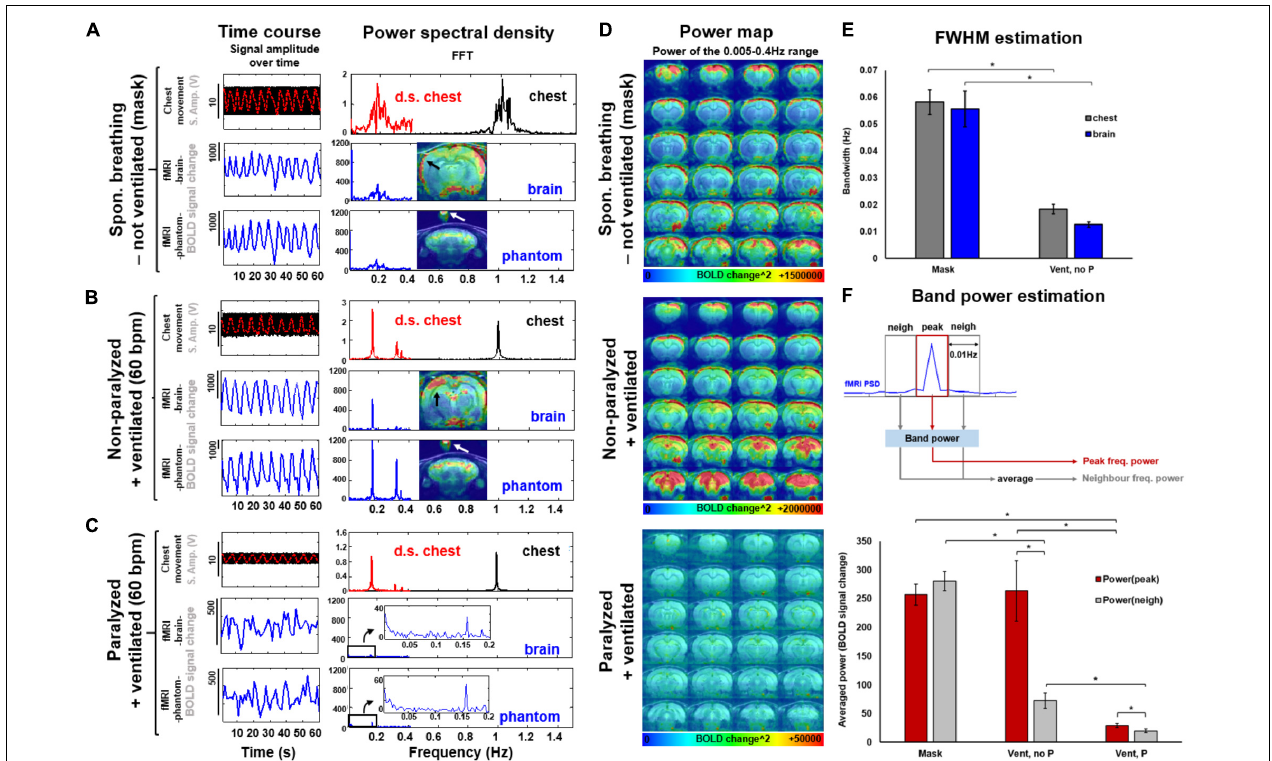
FIGURE 2 | Spectral and spatial characterization of the respiratory interference at 3 conditions: spontaneously breathing through a mask, ventilated and ventilated while paralyzed. (A,B,C) The original chest movement recorded at a sampling rate of 5000 is shown as a black trace. The down-sampled chest-motion (resampled at 1/TR) is shown in red. Note the smaller amplitude of this signal in the paralyzed condition (C , vs. A or B) . The fMRI time course of a voxel in the brain or in a phantom (over the animal’s head) is shown in blue. The frequency decomposition of the signals is shown on the right. Note the similarity between the spectra of the aliased chest and fMRI signal. (D) The power maps show the distribution of the interference for each condition (averaged from 5 different animals). Note the low power scale in paralyzed animals. (E) The graph shows the spectral FWHM (i.e., spreading) of the peak breathing frequency and the aliased signal in the fMRI time course for non-intubated (mask, N = 26) and ventilated non-paralyzed animals ( N = 17). (F) The graphs show the averaged power calculated within a frequency range that contains either the peak frequency (i.e. aliased from chest motion) or the limiting/neighbor frequency bands. N (Mask) = 16 trials from 4 animals, N (Vent,noP) = 16 trials from 3 animals, N (Vent,P) = 14 trials from 4 animals. Statistical test within conditions: two-tailed paired t -test. Statistical test between conditions: two-tailed not-paired t -test. ( ∗ ): p -value <